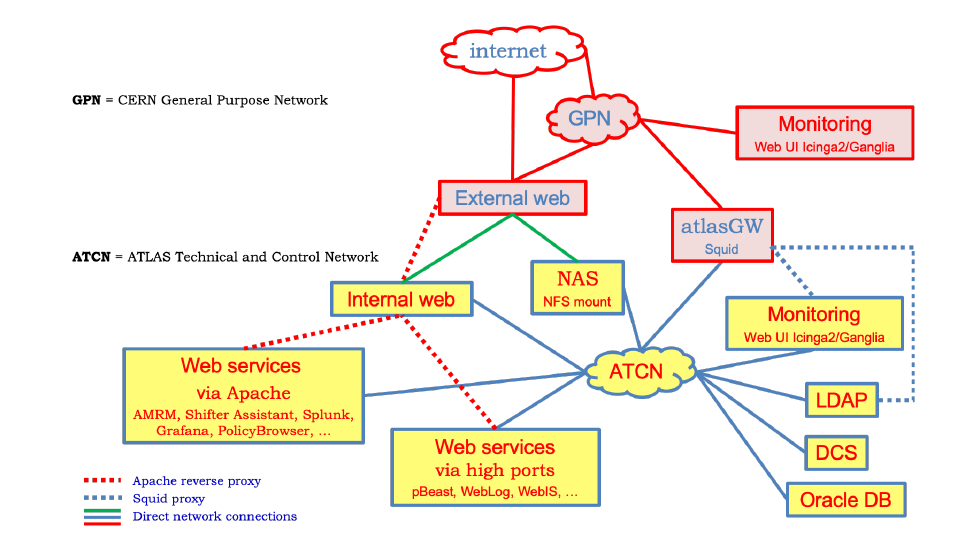
Figure 1. ATLAS Current Web Service